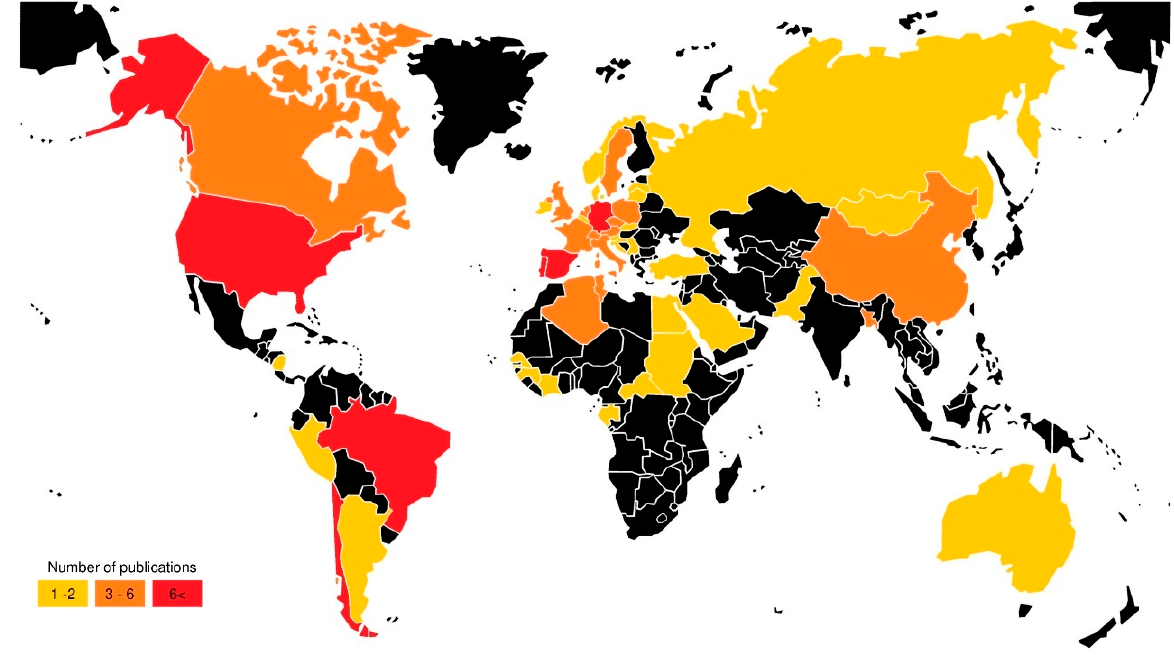
Figure 5. World map showing countries with publications reporting cephalosporinases in wildlife. Different realities and characteristics stand out when analysing each continent